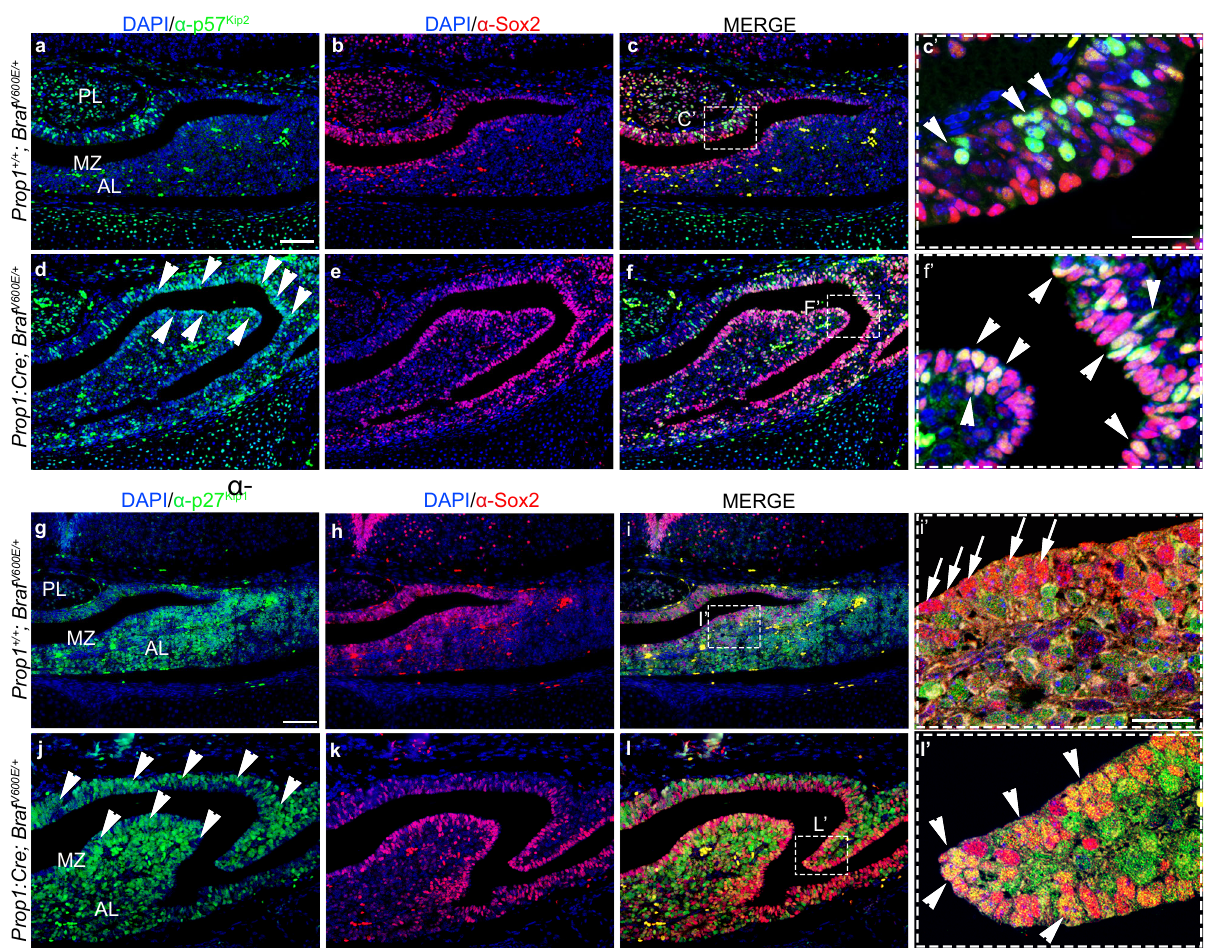
Fig. 9 Activation of ERK/MAPK pathway by expression of Braf V600E results in increased expression of the cell cycle inhibitors p57 Kip2 and of p27 Kip1 in the Sox2 + ve stem cells at E18.5. a – l Coronal sections through the pituitary gland at E18.5 of Wt ( a – c, g – i ) and Prop1:Cre;Braf V600E/ + ( d – f , j – l ). Double immuno fl uorescence against cell cycle inhibitor p57 Kip2 (green, a – f ) and p27 Kip1 (green, g – l ) with the pituitary stem cell marker Sox2 (red, a – l ). The cell cycle inhibitor p57 Kip2 was found to be upregulated in the Prop1:Cre;Braf V600E/ + pituitaries (arrowheads in d ) compared to the Wt ( a ). c ′ , f ′ Merged enlarged images of squared areas in c and f reveal increased p57 Kip2 immunoreactivity co-localising with Sox2 (arrowheads in f ′ ) in the Prop1:Cre;Braf V600E mutant pituitaries compared to Wt (arrowheads in c ′ ). Expression of p27 Kip1 (arrowheads in j ) is observed in the marginal zone (MZ) of the mutant pituitaries compared to Wt ( g ). Confocal merged images of the marginal zone revealed co-localisation of Sox2 with p27 Kip1 in the mutant Prop1 : Cre; Braf V600E/ + pituitaries (yellow nuclei, arrowheads in l ′ ), while no co-localisation of p27 Kip1 and Sox2 was seen in Wt pituitaries (arrows in i ′ ). i ′ , l ′ are enlarged images of the squared areas in i and l respectively. Images are representative of three embryos per genotype. AL anterior lobe, MZ marginal zone, PL posterior lobe. Scale bars in a and g represent 200 µ m. Scale bars in c ′ and i' represent 25 µ